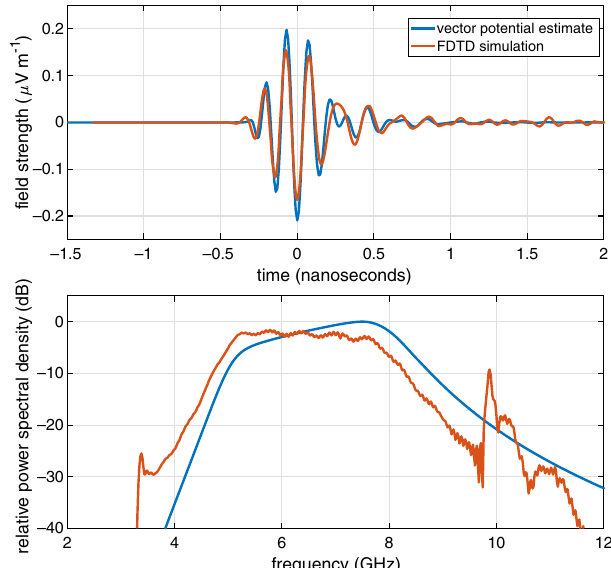
FIG. 1. Top: waveforms for a single electron transit of a WR51 waveguide loaded with alumina. The estimate from vector potential theory is shown in blue, and data from an XF simulation are shown in red. Bottom: power spectral density for the two waveforms in the top pane. A causal passband filter has been applied to emphasize the TE 10 mode response for the two